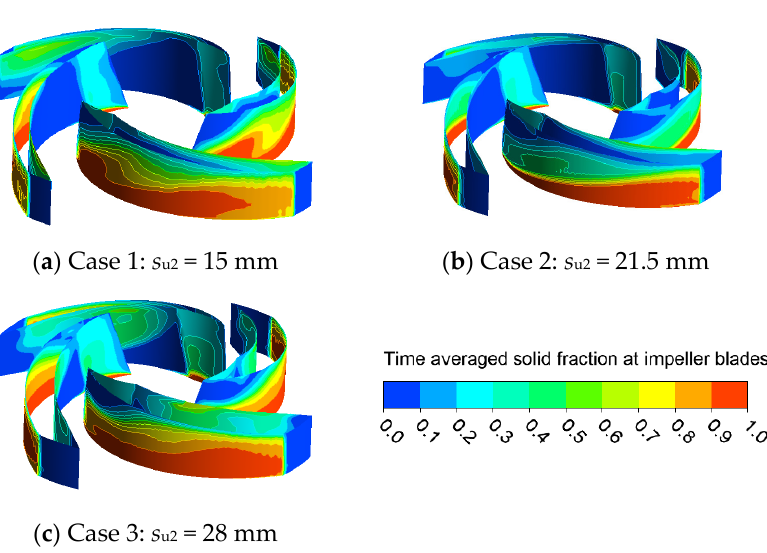
Figure 3. Contours of the time-averaged solid fraction on the surfaces of the impeller blades.